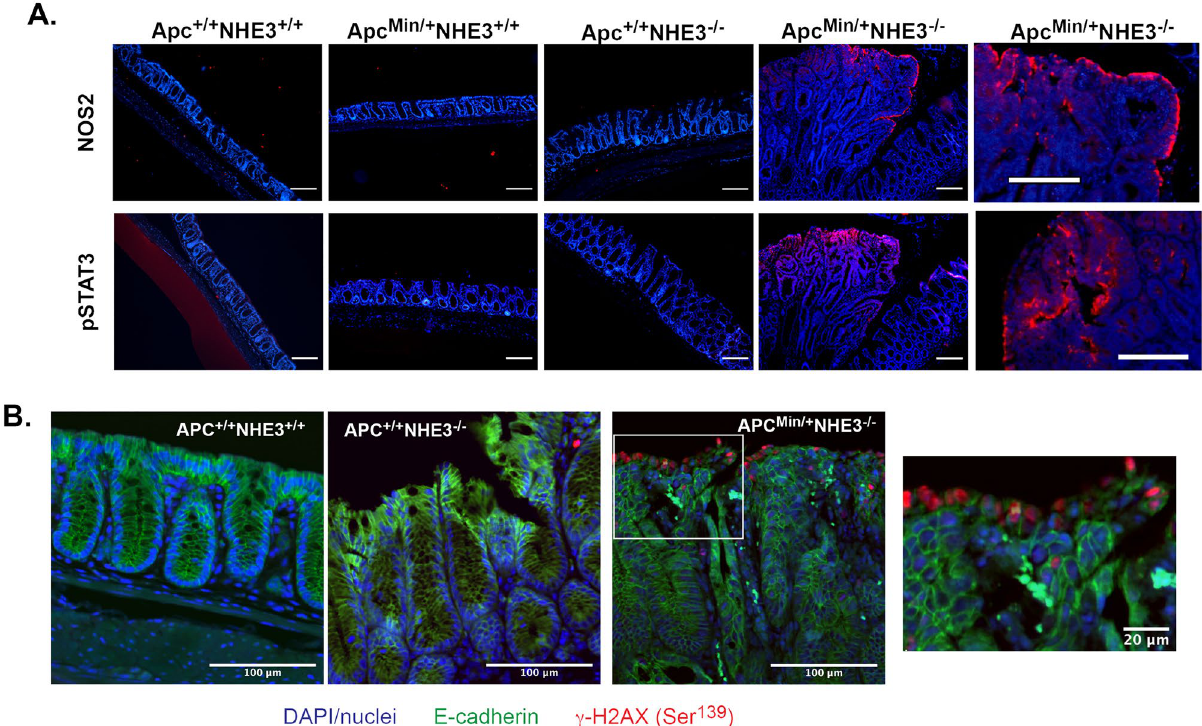
Figure 3. Tumor surface epithelia in Apc Min/+ NHE3 −/− mice show increased level of NOS2, activation of STAT3, and DNA damage. ( A ) Representative immunofluorescence (IF) staining for NOS2 and pSTAT3 (both in red), with blue DAPI nuclear counterstaining in all four genotypes. The white scale bars represent 200 μm. High magnification images of NOS2 and pSTAT3 IF from Apc Min/+ NHE3 −/− mice are in the rightmost two panels. ( B ) DNA damage (double stranded DNA breaks) was evaluated by immunofluorescent staining for phosphorylated histone H2AX (γ-H2AX). Tissue specimens were stained for γ-H2AX (red), E-cadherin (green), and nuclei were counterstained with DAPI (blue). The scale bars represent 100 mm or 20 mm for the higher magnification Firmicutes were significantly increased in NHE3 deficient mice comparing to NHE3 +/+ mice (both on Apc +/+ background), whereas genera Eisenbergiella , Oscillibacter, Ruminococcaceae _UCG—013, Harryflintia , GCA— 900066575, Ruminiclostridium , Ruminiclostridium _6, Ruminococcaceae (UCG_003 and UCG_010), Lachno- spiraceae (UCG_006, FC020_group, and UCG_001), A2, Clostridium_sensu_stricto _1, Acetatifactor , UBA1819, Ruminococcus _1, and Anaerosporobacter showed significantly decrease abundance (Fig. S3A). Several genera were assigned to more than one ASV (e.g. Lachnospiraceae _NK4A136_group, Roseburia , Ruminococcaceae _UCG— 014, Ruminiclostridium _5), however majority of the ASVs showed decreased abundance in NHE3 deficient mice, except for the genus Anaerotruncus and Lachnoclostridium for which two out of three ASVs increased in NHE3 −/− mice (Supplementary Fig. S3A). We also observed a significant increase in the genus Enterorhabdus form the phylum Actinobacteria and Muribaculum from the phylum Bacteroidetes . A bile tolerant, sulphate reducing bacteria from the genus Bilophila , phylum Proteobacteria , were significantly decreased in NHE3 −/− mice. Taxonomic composition analysis in fecal samples from all four genotypes showed that NHE3 deficiency was a dominant factor modulating gut microbiome, and both NHE3-deficient genotypes appeared to be similar (Supplementary Fig. S3B). Nevertheless, DESeq2 differential abundance comparison of Apc +/+ NHE3 −/− and Apc Min/+ NHE3 −/− mice identified several significantly different taxa (Fig. 4E). In this case, introduction of the Apc Min allele was associated with increased relative abundance of Acetatifactor , Lactobacillus , Ruminococcaceae UCG-014 , Lachnospiraceae _NK4A136_group, Anaerosporobacter , Oscillibacter , Riminococcus _1, Ruminococ- caceae_UCG013 , and Ruminiclostridium . Only Lachnoclostridium and Dubosiella showed significant decrease (Fig. 4E). Faecalibaculum genus with only one species, F. rodentium , which was recently reported to reduce tumor growth in Apc Min/+ model 35 , showed increasing tendency in our Apc Min/+ mice, regardless of the NHE3 status (Fig. 4F), though without reaching statistical difference. Spearman’s rank correlation coefficient analysis (Fig. 4G) showed high correlation between selected genera and the tested proinflammatory cytokines. Erysipelatoclostridium was highly positively correlated with increased IL-22, TNFα, NOS2, and IL-6 and negatively correlated with Ruminiclostridium, Acetatifactor , Anaerosporobac- ter, Roseburia, Eisenbergiella and other genera involved in SCFA metabolism. IL-6 and INFγ were positively correlated with Coriobacteriaceaea _UCG-002 and GCA-900066575. To a lesser extent, the selected inflamma- tory mediators were positively correlated with genus Romboutsia , Lactobacillus , Turicibacter and Muribaculum (Fig. 4G, red triangle). All genera considered as SCFA producers with a reported positive impact on the gut health were positively correlated to each other and clustered together (Fig. 4G, green triangle).